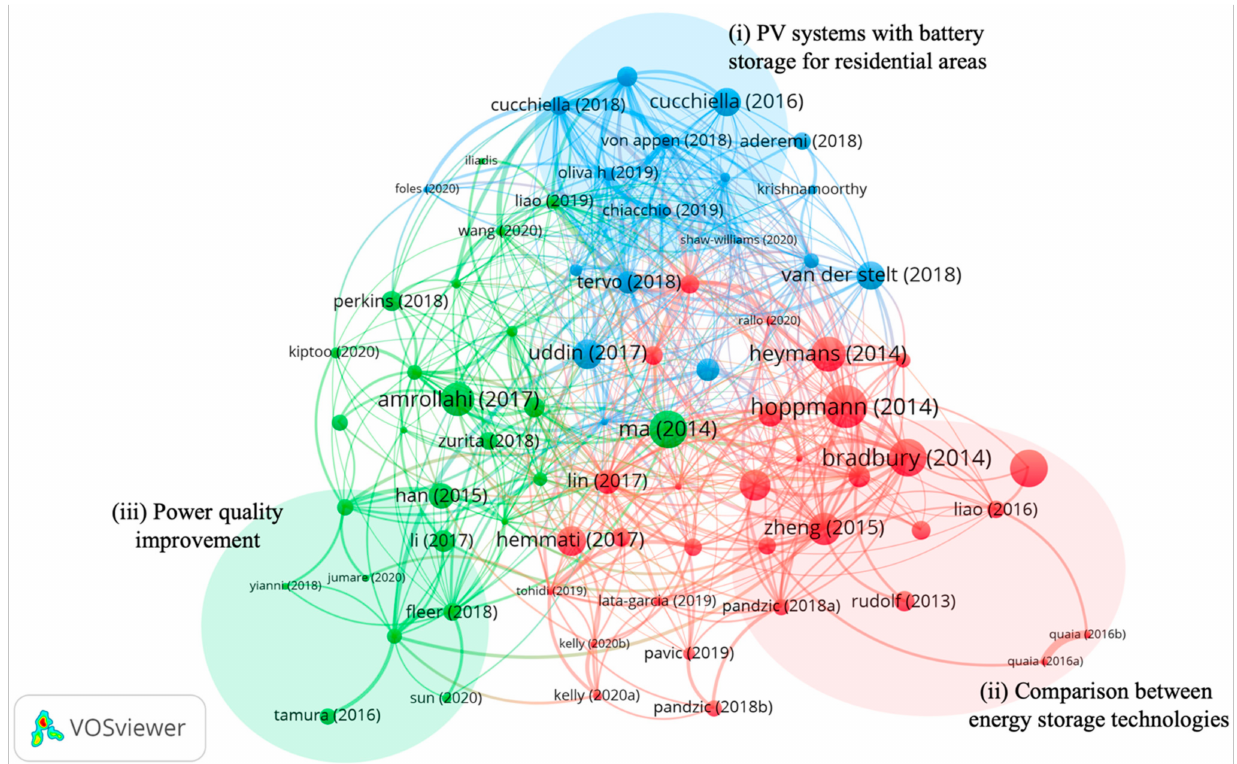
Figure 10. Predominant cluster framework based on the bibliographic coupling